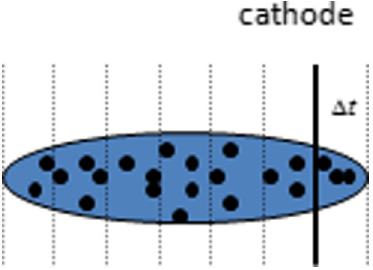
FIG. 17. A schematic plot of the electron emission process at the